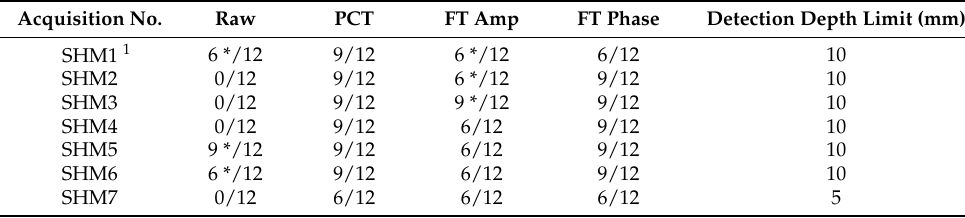
Table 12. Step-heating results from the inspection of the monolithic CFRP sample. Acquisition